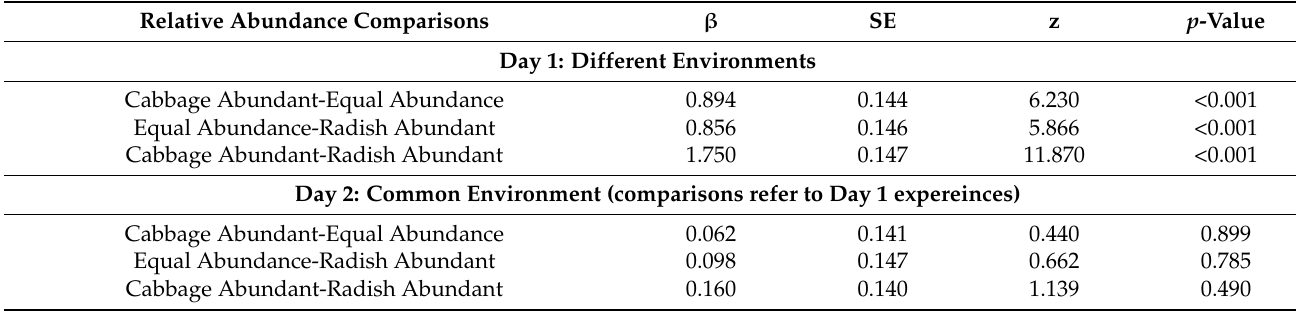
Table 1. Results of post hoc Tukey comparisons predicting a butterfly’s probability of landing on cabbage. On Day 1, butterflies foraged in one of three environments that differed in the relative abundance of host plants radish and cabbage. On Day 2, these same butterflies foraged in a common environment where the two hosts were equally